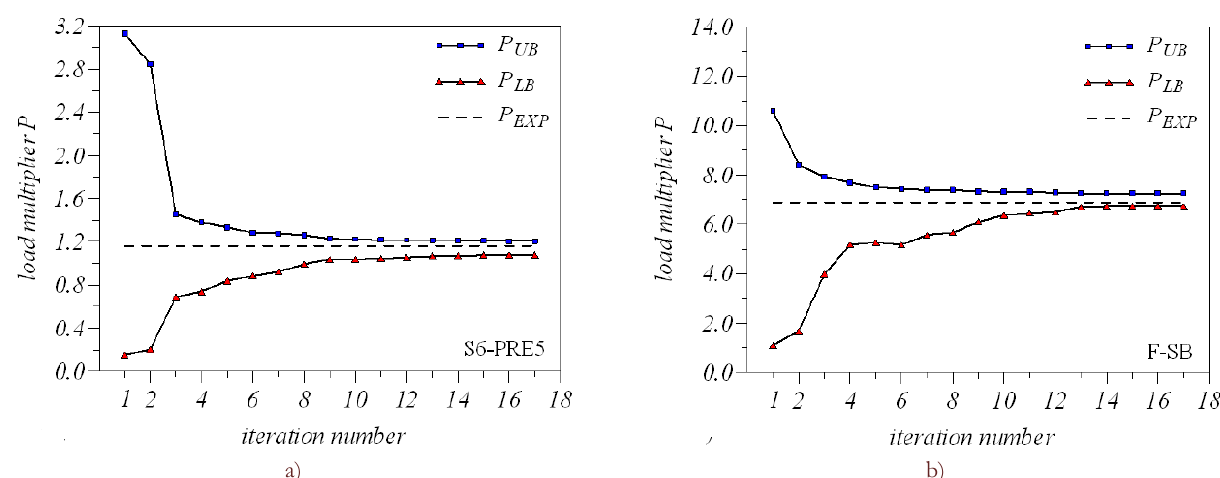
Figure 5: Values of the upper ( P ) and lower ( P ) bounds to the peak load multiplier versus iteration number against to the collapse UB LB ): a) specimen S6-PRE6; b) specimen experimental threshold ( P EXP